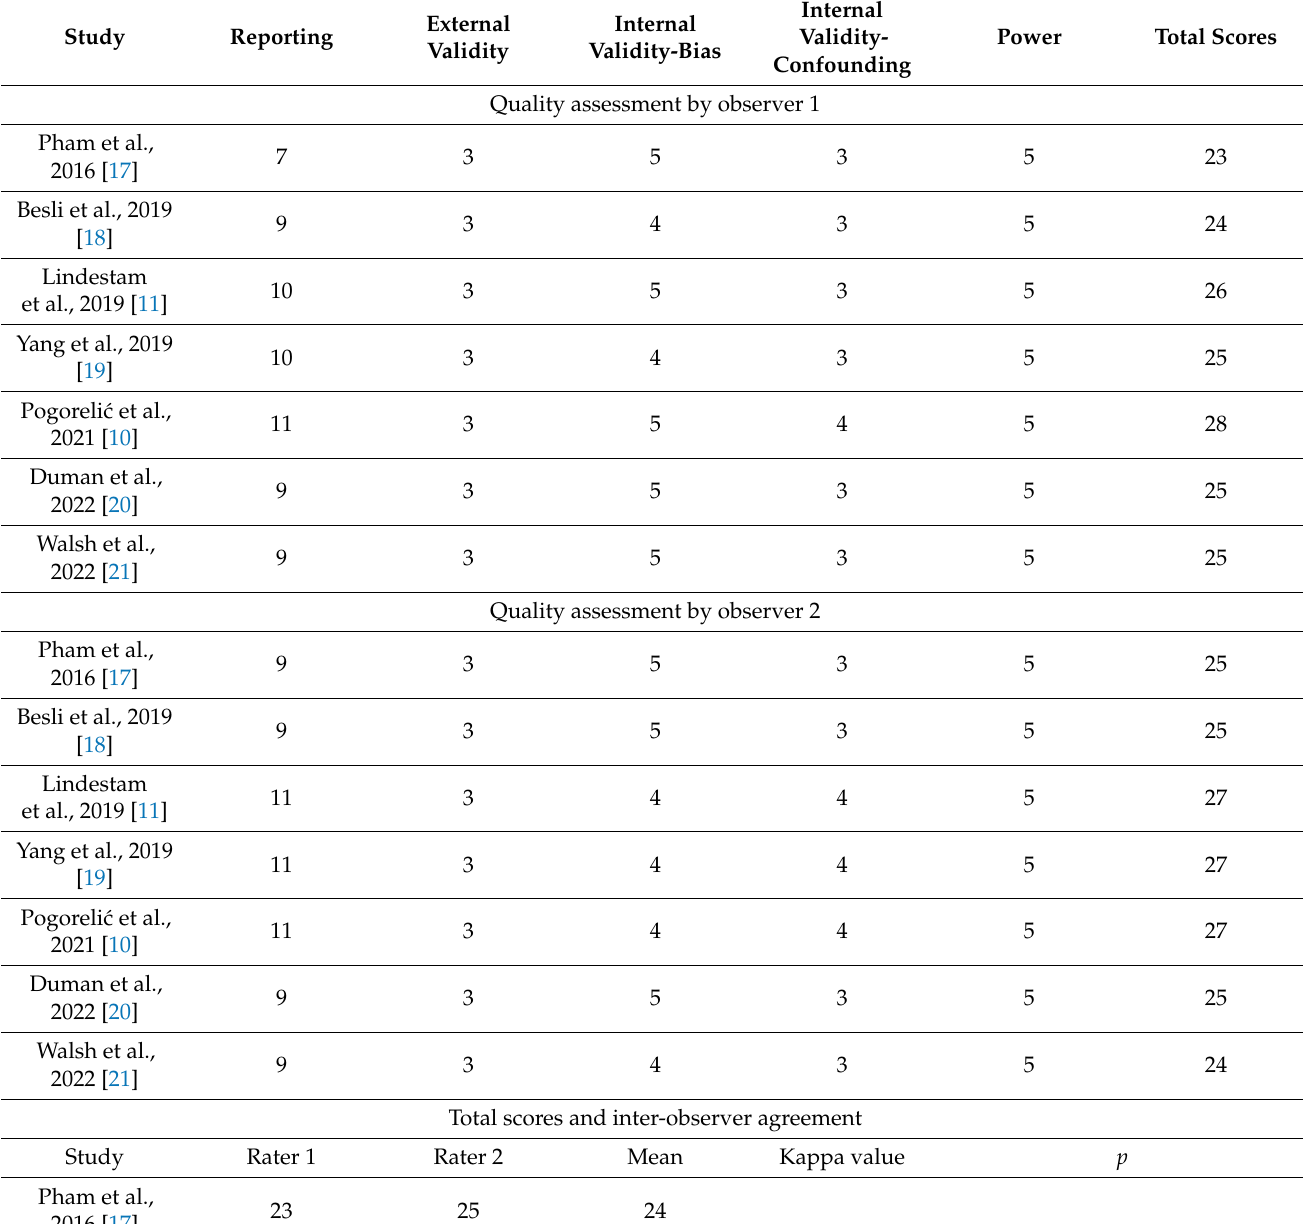
Table 2. Independent methodological quality assessment by two observers utilizing the Downs and Black